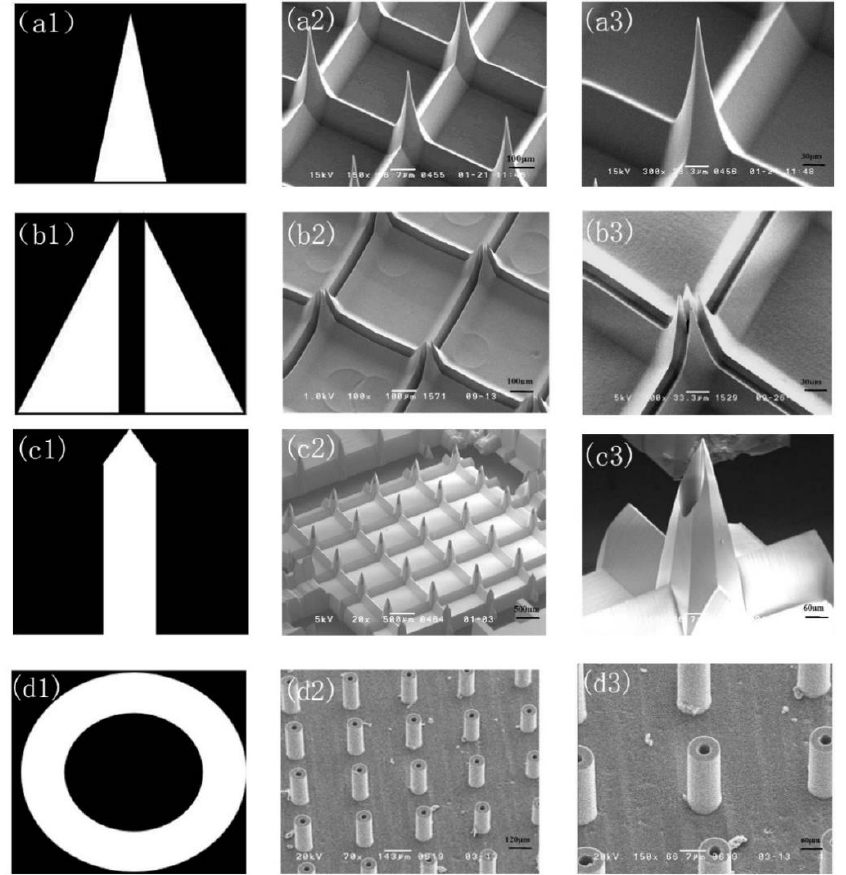
Figure 6. Fabrication results of PMMA out-plane MNA. ( a1 ) Triangular absorber pattern. ( a2 ) Out-plane solid MNA. ( a3 ) An enlarged image of ( a2 ). ( b1 ) Double right triangle absorber pattern. ( b2 ) Out-plane blood extraction MNA. ( b3 ) An enlarged image of ( b2 ). ( c1 ) Obelisk shaped absorber pattern. ( c2 ) Out-plane hollow MNA. ( c3 ) An enlarged image of ( c2 ). ( d1 ) Concentric circular absorber pattern. ( d2 ) Out-plane hollow MNA. ( d3 ) An enlarged image of ( d2 ).